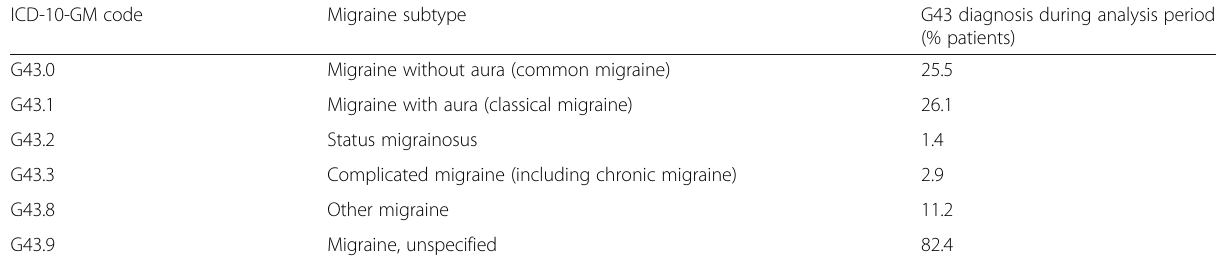
Table 1 Migraine diagnosis by subtype (ICD-10-GM code) in the German Company Sickness Fund Database 2008 to